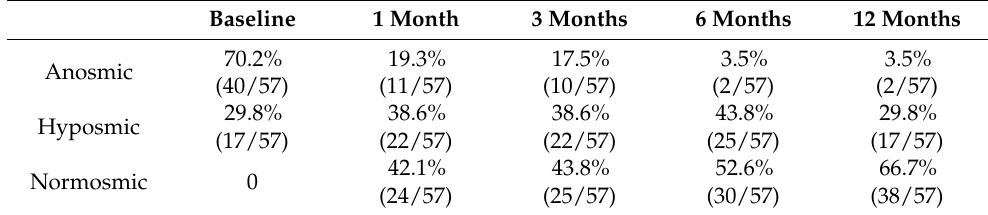
Table 2. Patient distribution based on results with the SSIT-16 over time.